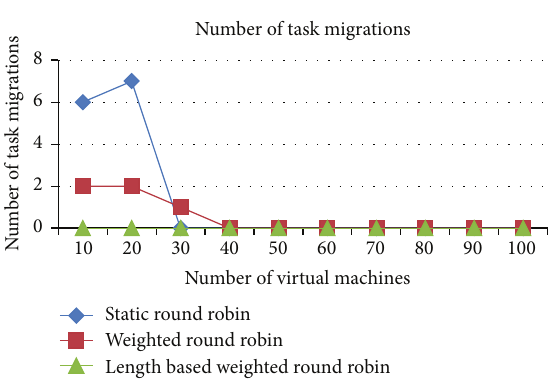
Figure 14: Number of task migrations (time